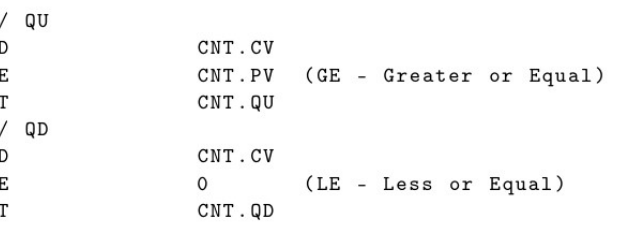
Figure 11. Software-like counters with conditioning. Listing 6. Proposed method of Counter outputs generating using standard PLC